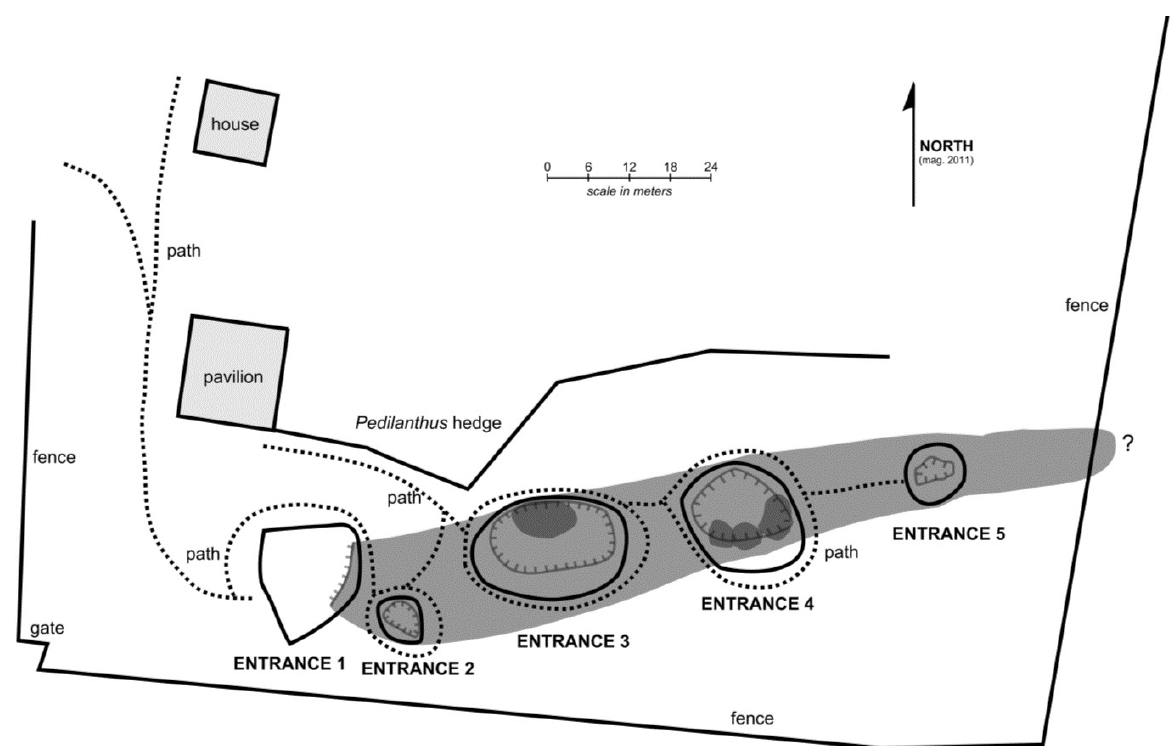
Figure 2. Diagram of the surface layout of the Monfort Bat Cave at the research site on Samal Island, Philippines. Illustration courtesy of Bat Conservation